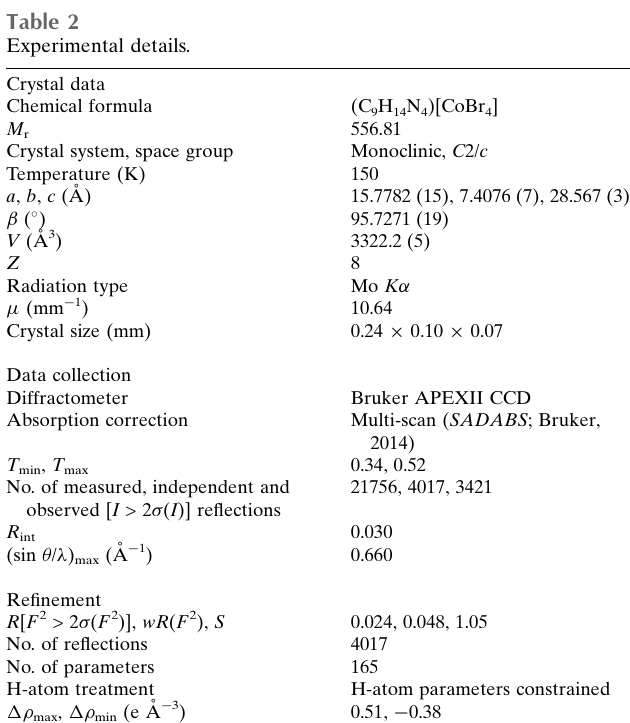
Table 2 Experimental details.